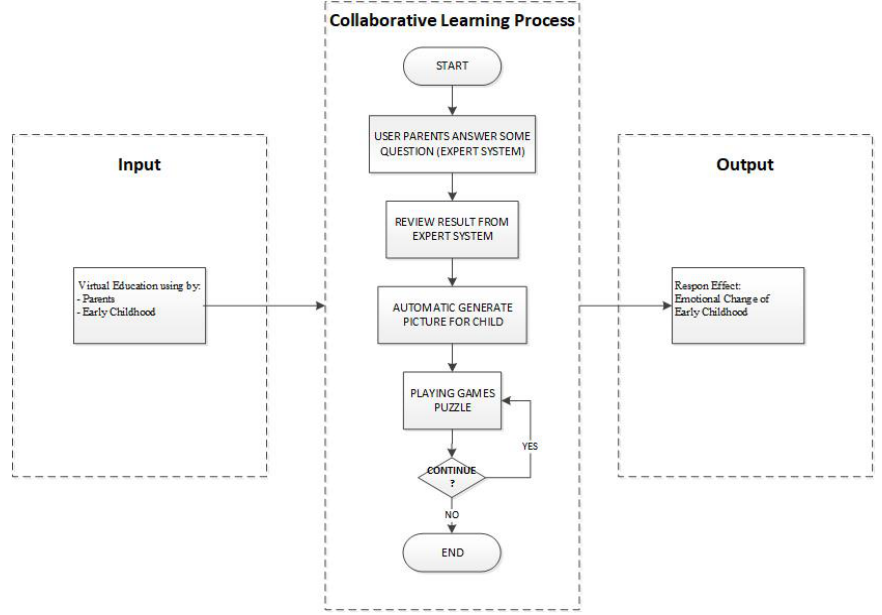
Fig. 1. Process application of Virtual Education Games Puzzle effect on emotional changes in normal children and children